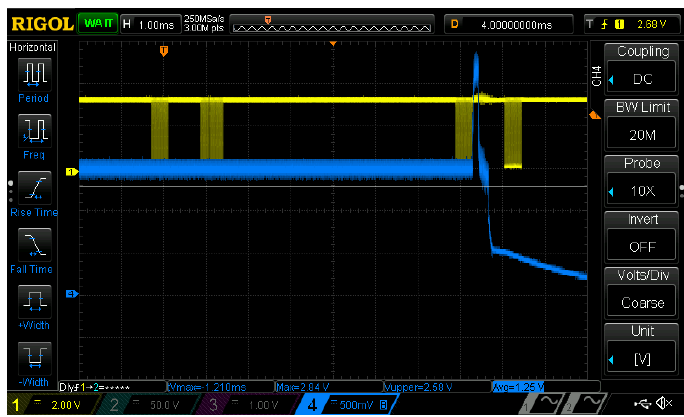
Figure 8: Oscillocope capture of voltage change during overvolting, VOUT_COMMAND set to 0xFF (with 10mV VID table). Yellow: PMBus clock, blue: V cpu . V cpu shoots up to 2.84V during overvolting.